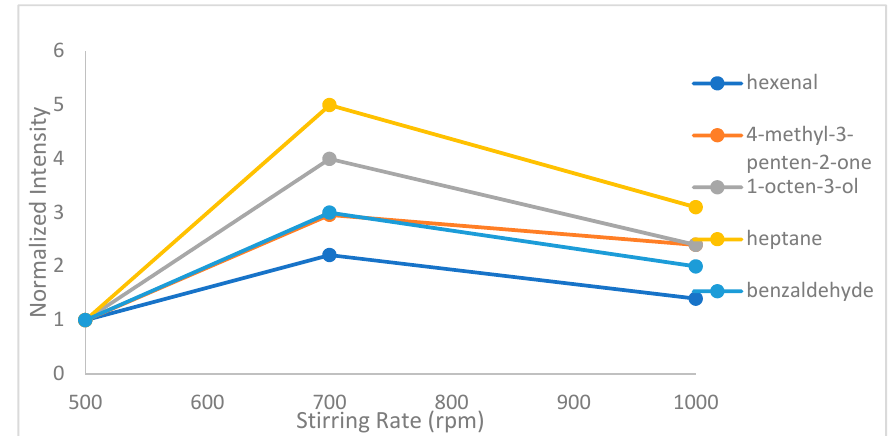
Figure 4. Effect of stirring rate on hexanal, 4-methyl-3-penten-2-one, heptane, benzaldehyde and 1- octen-3-ol.